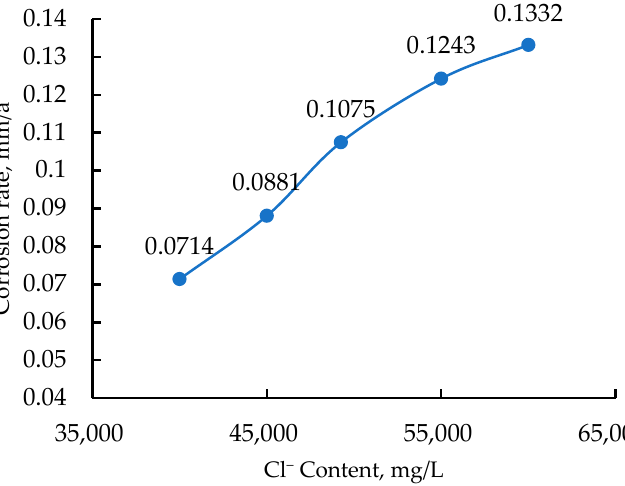
Figure 9. Variation curve of dynamic corrosion rate of 20# steel with Cl − content.